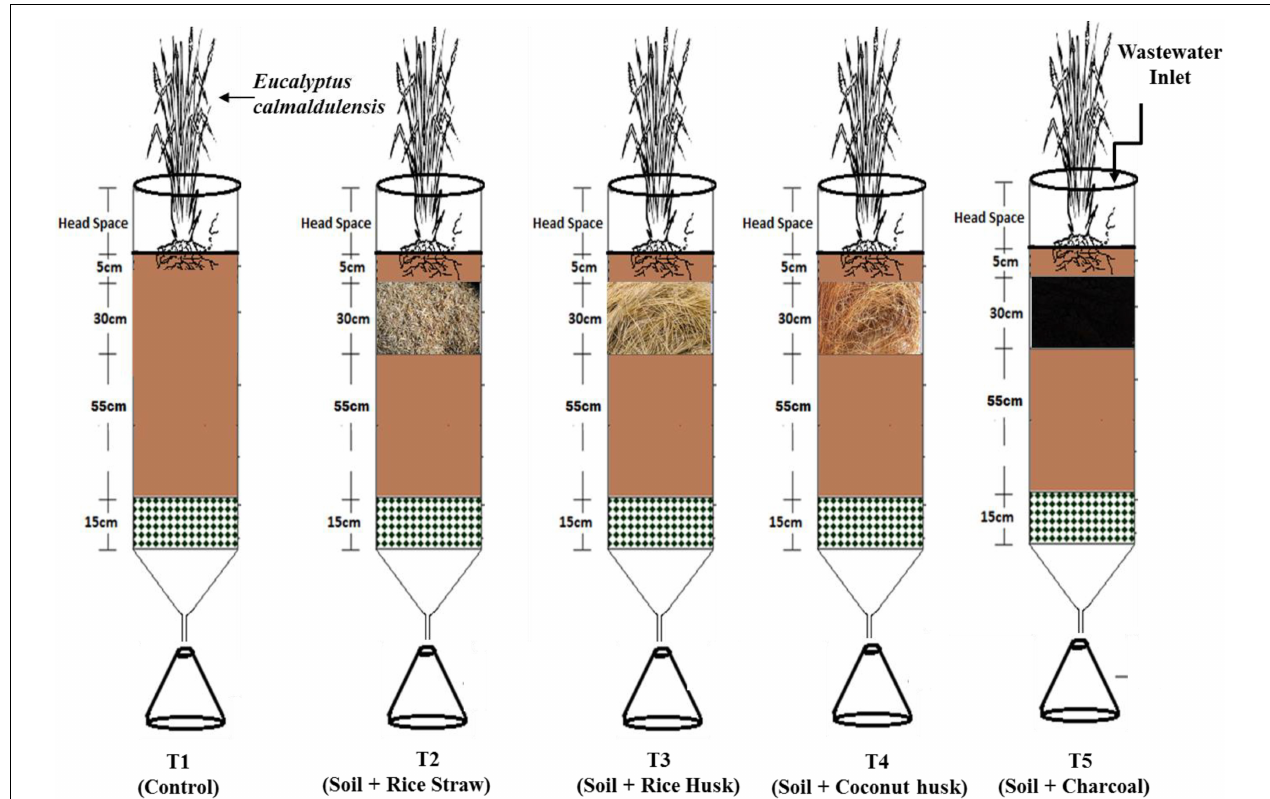
FIGURE 1 | Experimental setup of different lysimeter